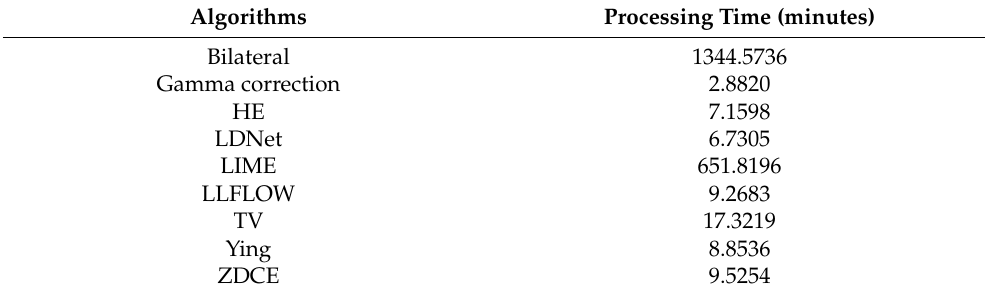
Table 2. Comparison of processing time taken by image enhancement algorithms (in minutes).